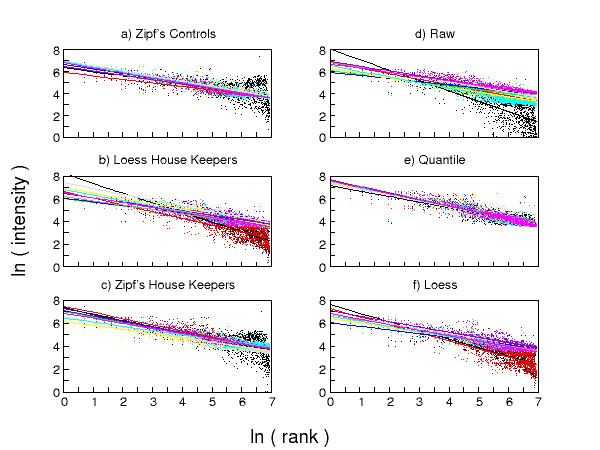
Boutique microarray log plots. Five mouse apoptosis boutique microarrays used in the mouse cell line experiments. Upper left to lower right: Loge median gene intensity vs. loge rank – a. Normalized according to Zipf's law, using internal positive and negative controls as proxies for the whole data set. b. Normalized with a loess curve fit using a selected set of housekeeping genes as proxies (see Methods). c. Normalized according to Zipf's law, using the same selected set of housekeeping genes as in b. as proxies d. The raw data. e. For comparison purposes only, normalized using the quantile method. f. For comparison purposes only, normalized using the standard loess method.